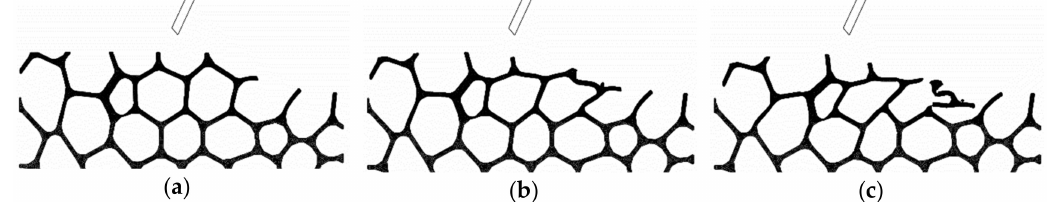
Figure 9. Workpiece–tool interaction (chip formation) during down milling (Model D, v c = 100 m / min, f z = 0.30 mm): 1st sweep ( a ); 2nd sweep ( b ); and 3rd sweep ( c